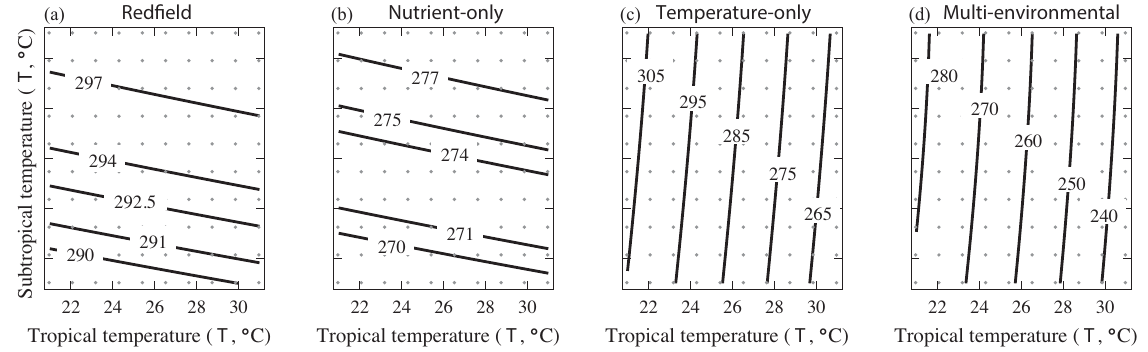
Figure 10. p CO 2 , atm (ppm) as a function of changing surface temperature concentrations. Based on (a) Redfield (fixed) stoichiometry model, (b) nutrient-only stoichiometry model, (c) temperature-only stoichiometry model, and (d) multi-environmental stoichiometry